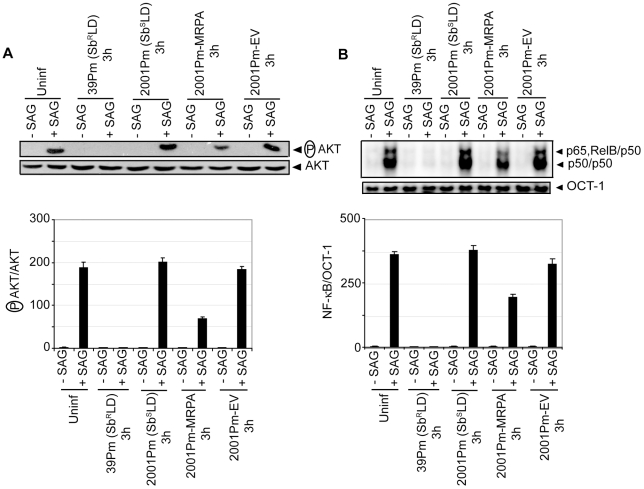
2001Pm-MRPA but not 2001Pm inhibits SAG-induced AKT phosphorylation and DNA binding activity of NF-κB.BMDCs were infected for 3 hours with 2001Pm (SbSLD), 39Pm (SbRLD), 2001Pm expressing MRPA (2001Pm-MRPA) or 2001Pm transfected with empty vector (2001Pm-EV) and stimulated with 20 µg/ml of SAG as described in Figure 4. (A) Expression of phosphorylated (P) AKT and AKT were measured in whole cell lysates via Western blot using the same membrane. Densitometric readings represent the ratio of intensity of phosphorylated (P) AKT protein to AKT expression per unit area and are represented as arbitrary units. (B) Nuclear NF-κB and OCT-1 DNA binding activities were measured via EMSA. Densitometric analysis represents the ratio of intensity of NF-κB to OCT-1 binding per unit area and is represented as arbitrary units. Data are representative of two independent experiments. Error bars indicate mean ± SD.